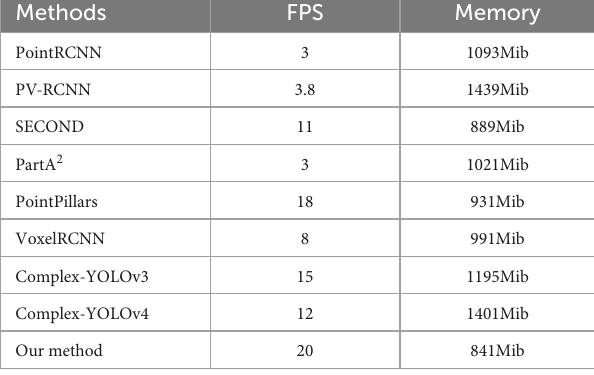
TABLE 6 Experimental results of comparison experiments with other